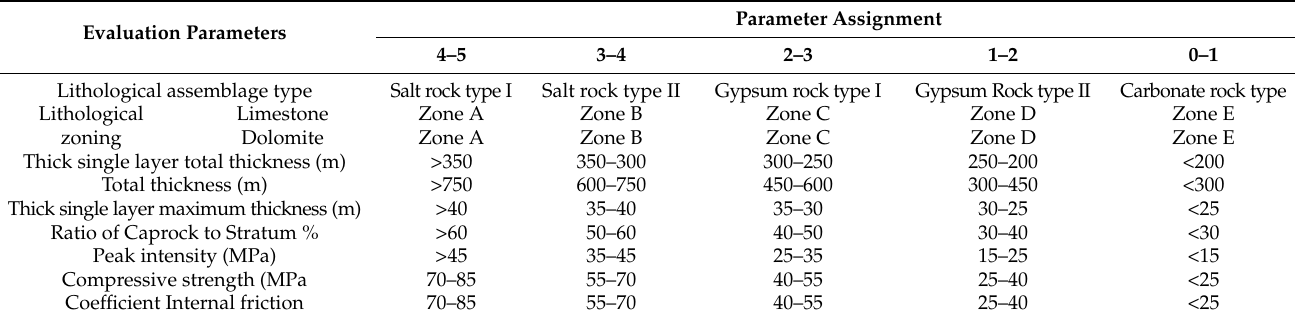
Table 2. Evaluation parameter assignment table of sealing capacity of Cambrian gypsum-salt rock caprock.